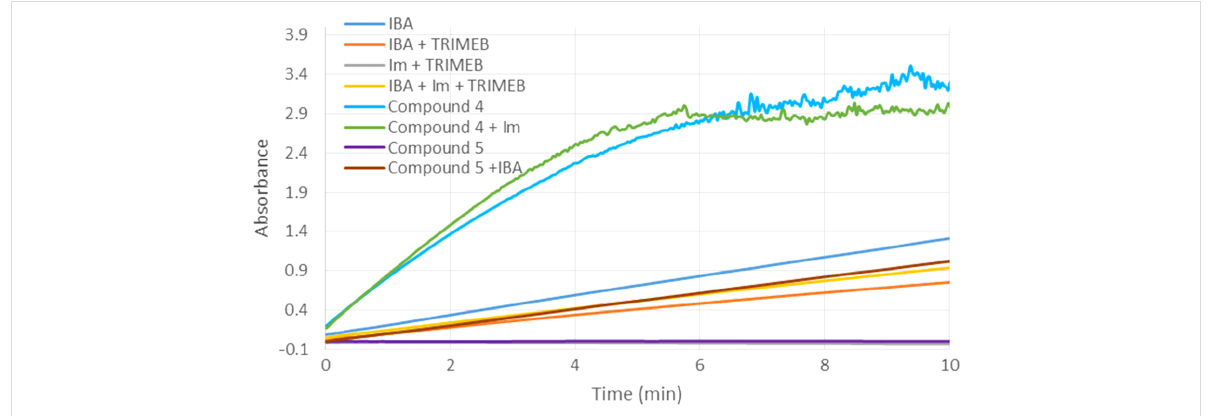
Figure 8: Hydrolysis of methyl paraoxon (0.5 mM) in the presence of mixtures of compounds 4 , 5 with IBA or imidazole and in the presence of a mix- ture of TRIMEB, 2-iodosobenzoic acid (IBA) and imidazole. The final concentrations of compounds 4 , 5 , 2-iodosobenzoic acid (IBA), imidazole and TRIMEB were 0.5